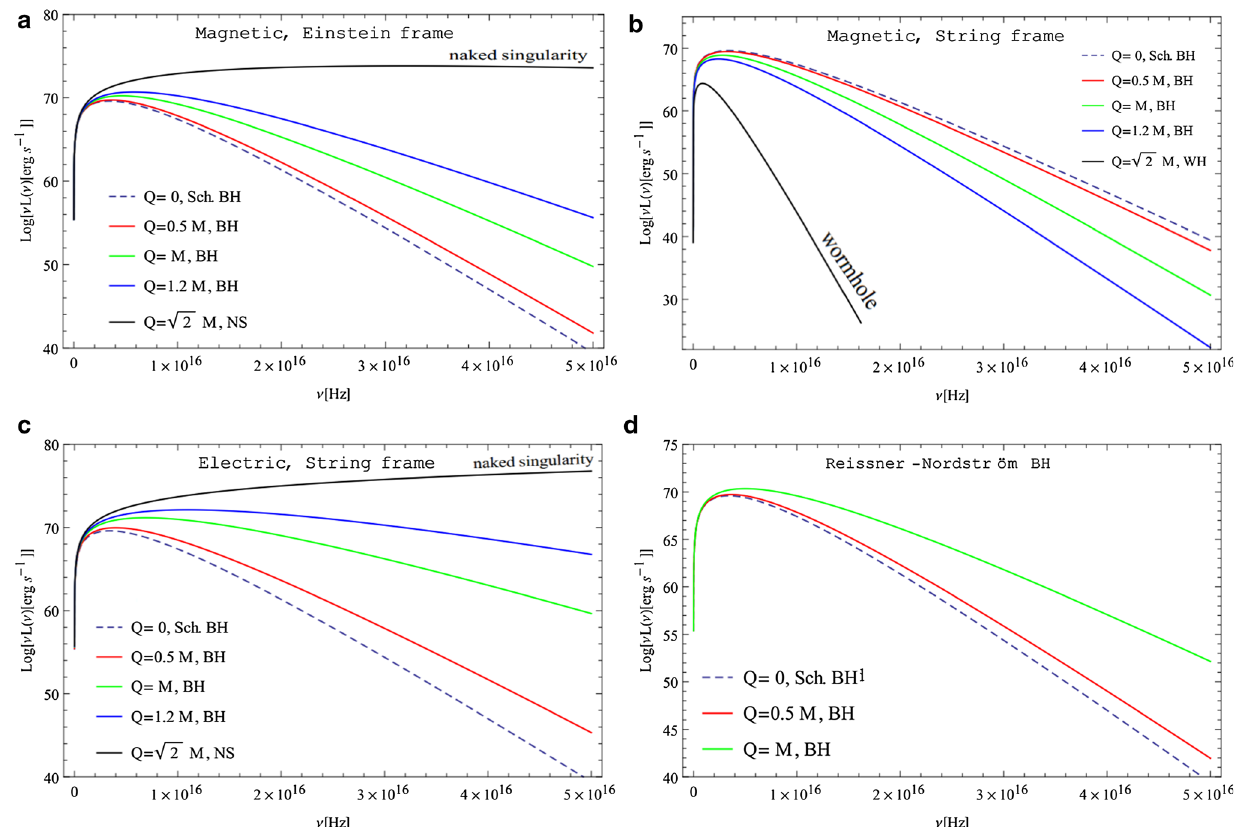
Fig. 6 The emission spectra ν L (ν) vs frequency ( ν in Hz) of the accre- tion disk with inclination i = 0 0 for a GMGHS BH in EF ( a ), mag- netically charged in the SF ( b ), electrically charged in the SF ( c ) and Reissner–Nordström BH ( d ) plotted for different values of Q . a shows √ that, at Q ≤ 2 M , ν L (ν) behaves like a BH of general relativity at the low frequency range but assumes a steady value until ν ∼ 10 19